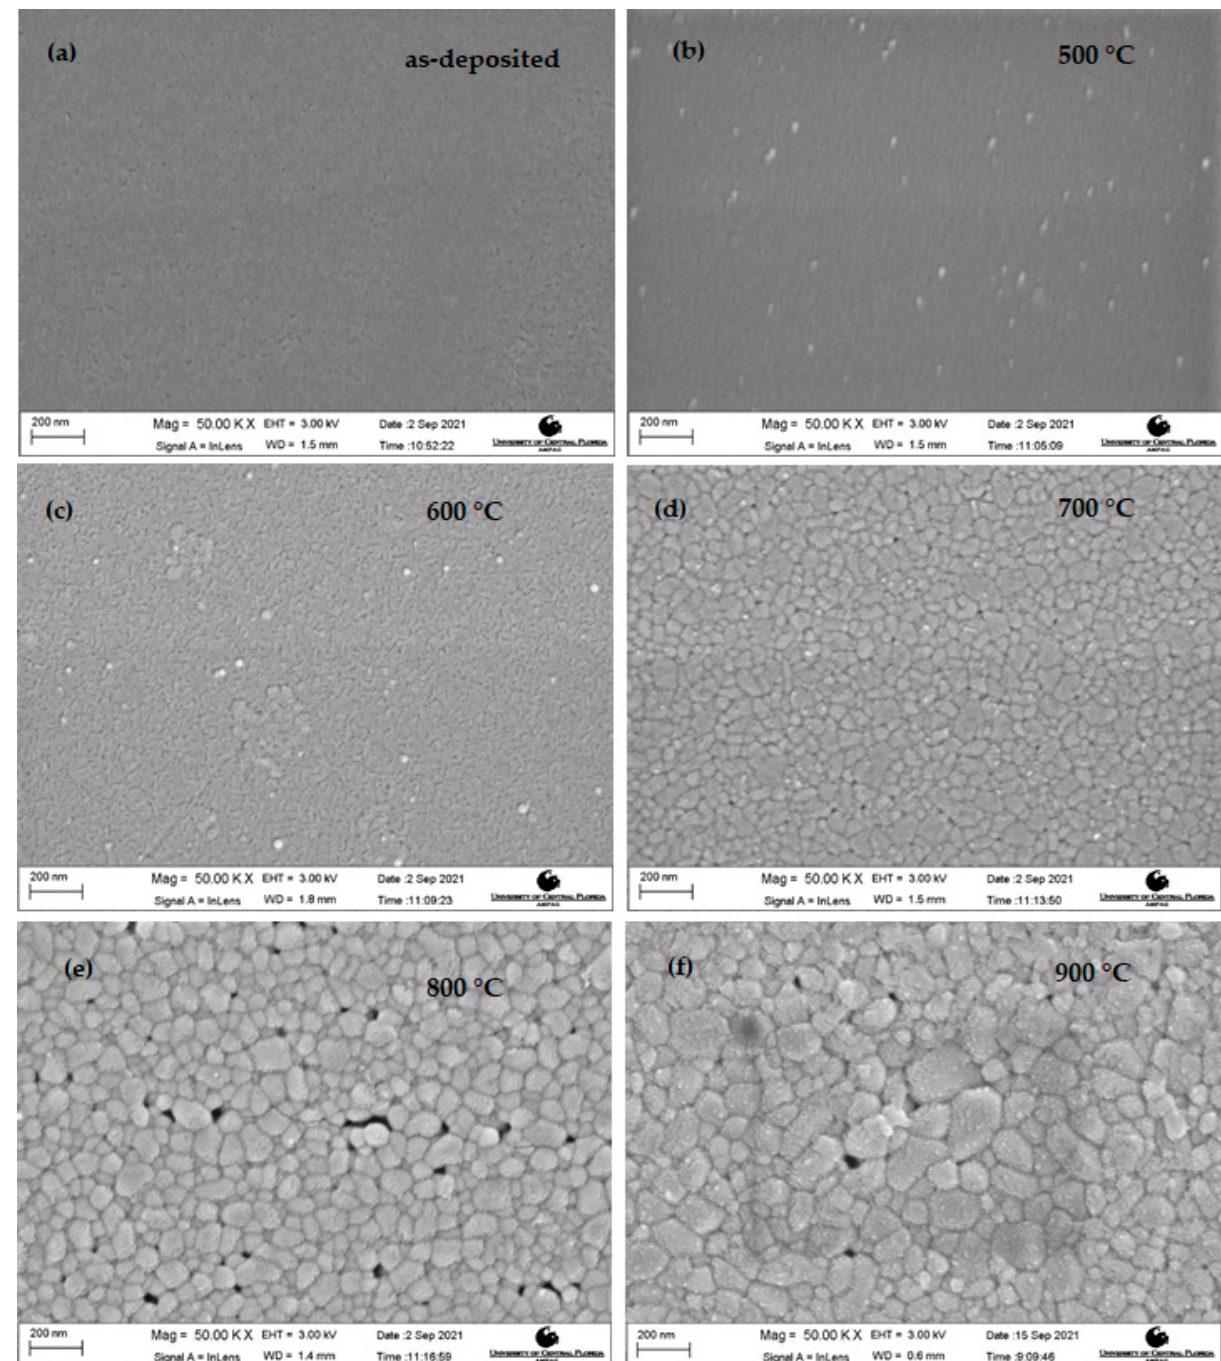
Figure 2. SEM images of Cu 2 In 2 O 5 films ( a ) as deposited and annealed at ( b ) 500 ° C, ( c ) 600 ° C, ( d ) 700 ° C, ( e ) 800 ° C, and ( f ) 900 ° C. ( f ) 900 ◦